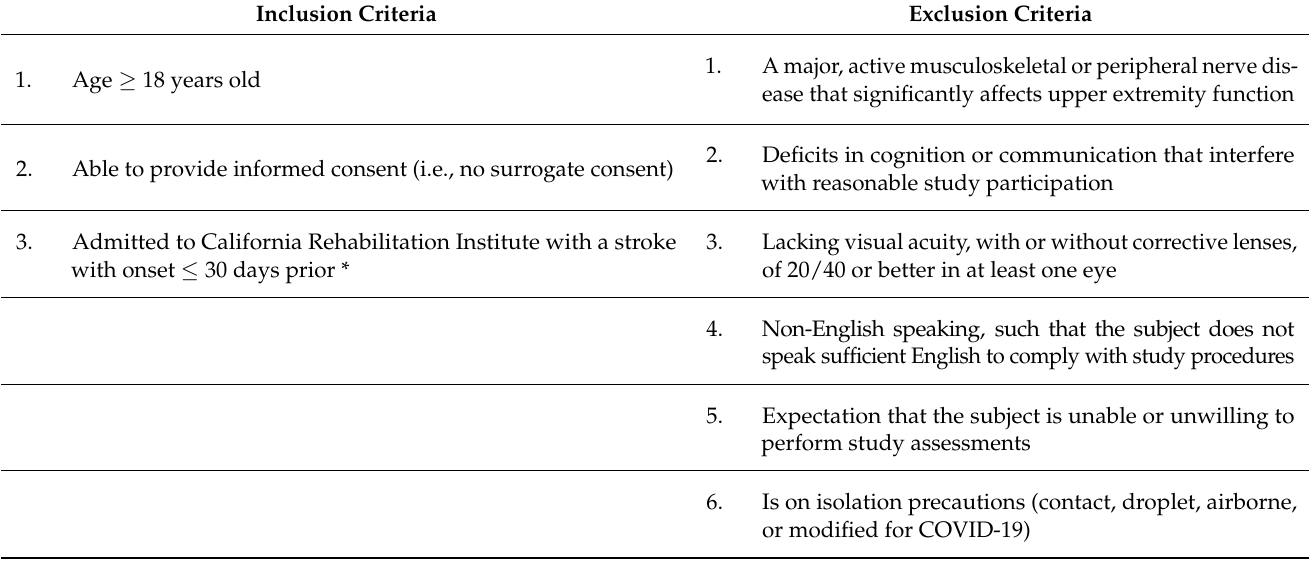
Table 1. Study Eligibility Criteria.